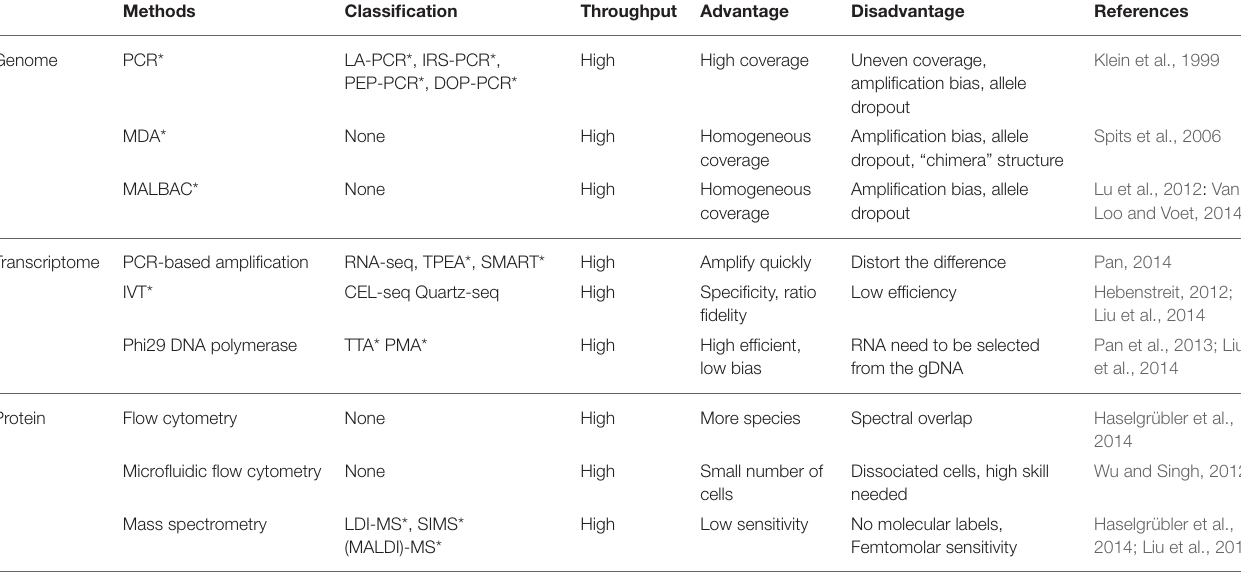
TABLE 2 | Techniques for single cell